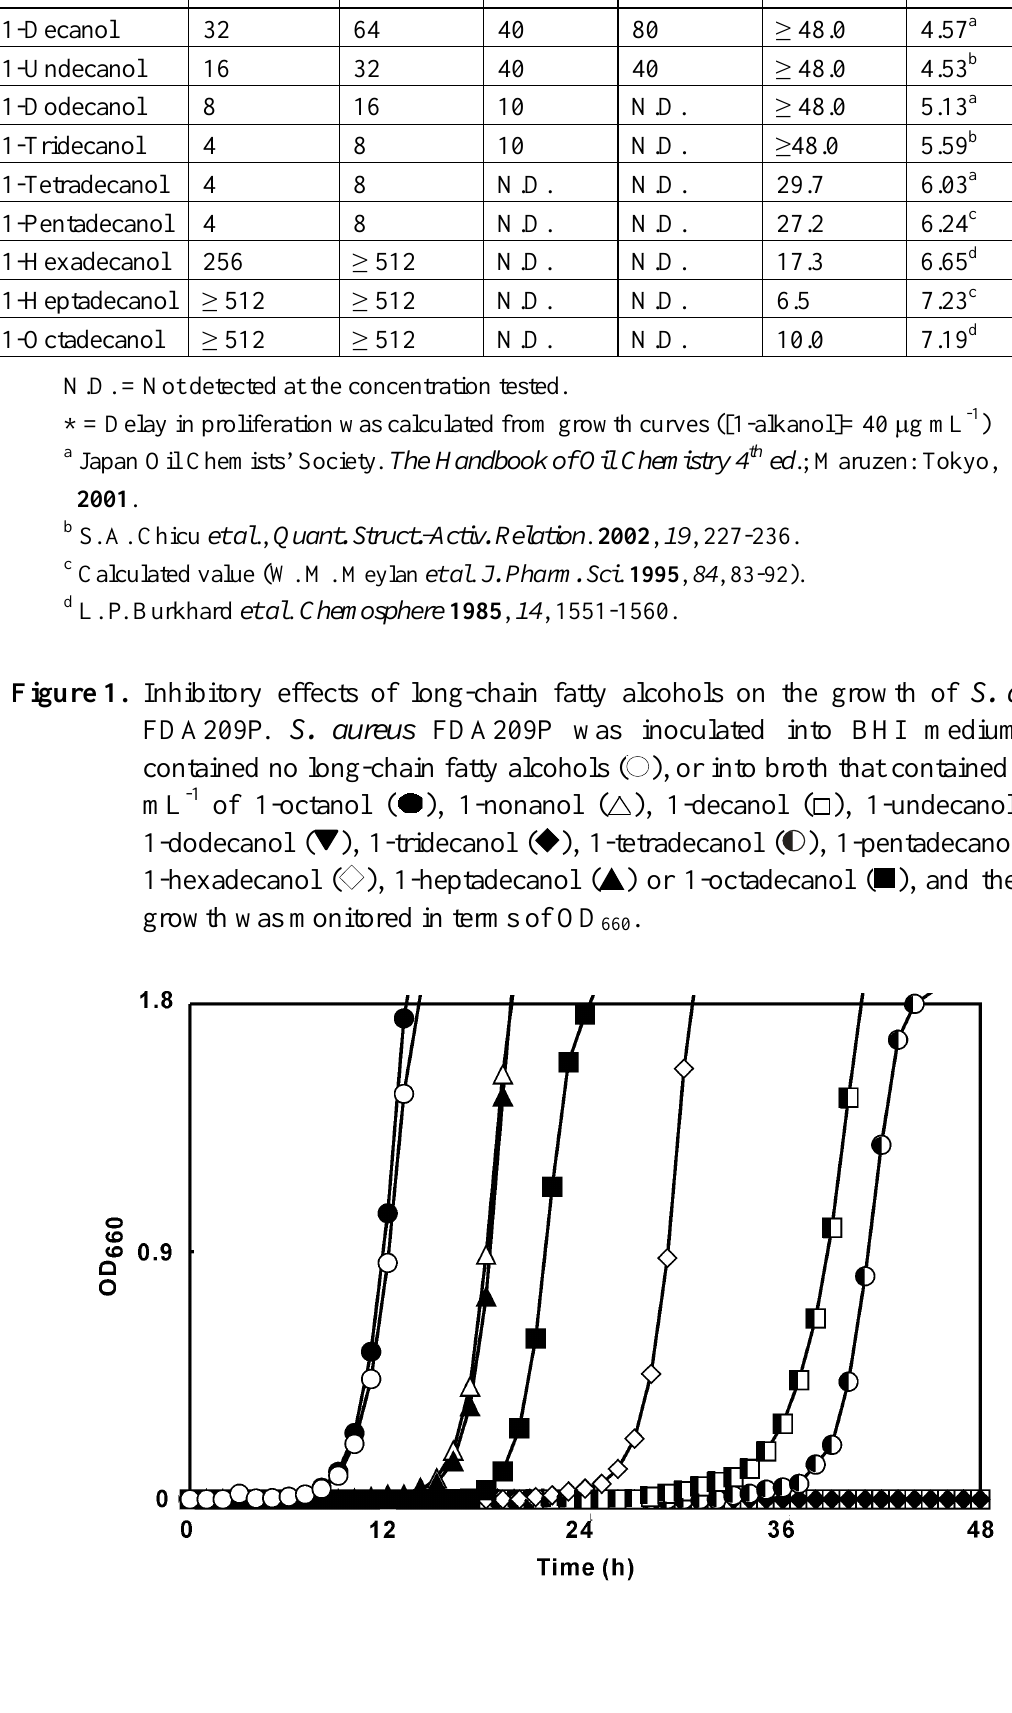
Table 1. Antimicrobial effects of 1-alkanols on the growth of S. aureus and n -octanol/water partition coefficients. Broth dilution method Broth dilution with shaking Alcohol MIC MBC MIC MBC DP* 1-Octanol 256 256 N.D. N.D.